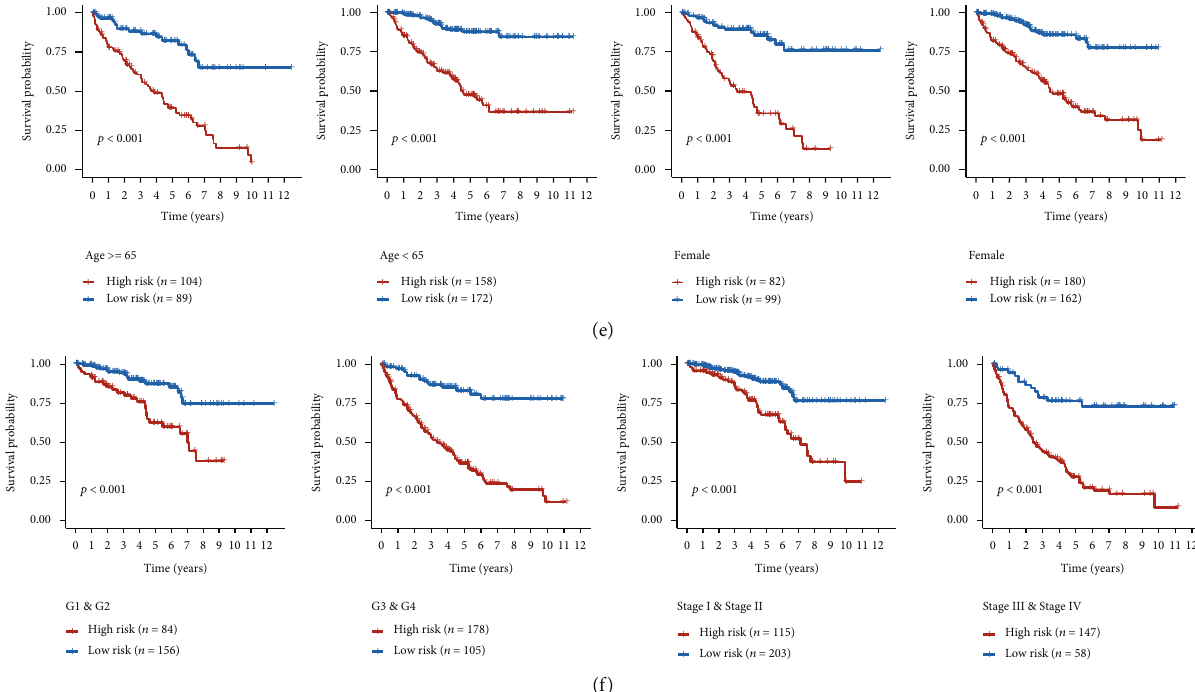
Figure 4: Construction of the risk score and its prognostic value. (a) The LASSO regression plot of the model partial likelihood deviance change (upper) and the regression coe ffi cients (lower). (b) The heat map of the patient status time and key gene expression ranked by their risk score in the training (left) and the independent cohort (right). The Kaplan-Meier curves (c) and the ROC results (d) estimate the prognostic value of the risk score. (e) The Kaplan-Meier curve showing the survival analysis results under di ff erent clinical feature conditions presents the independent prognostic value of the risk